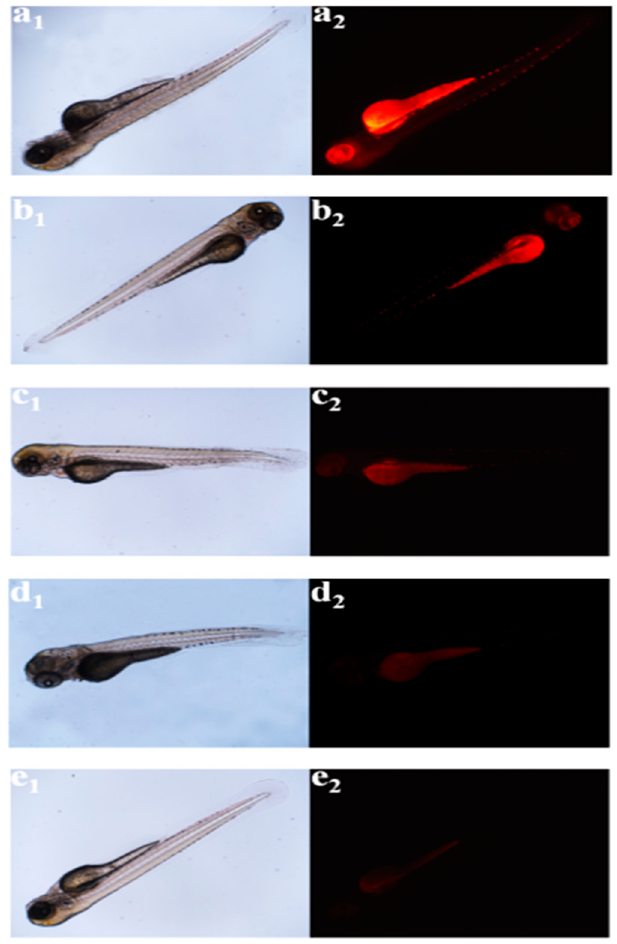
Figure 9. FL imaging of Pt 2+ in ZF: ( a 1 − e 1 ) Optical images and ( a 2 − e 2 ) FL images stemming from C-dots in ZF loaded with several concentrations of Pt 2+ : 0 ( a 1 , a 2 ); 30 ( b 1 , b 2 ); 60 ( c 1 , c 2 ); 100 ( d 1 , d 2 ) and 150 μ M ( e 1 , e 2 ). Reprinted (adapted) with permission from [75]. Copyright 2021 American Chemical Society.